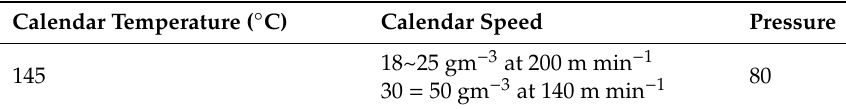
Table 2. The mechanical properties of the PP nonwoven fabric fibers.